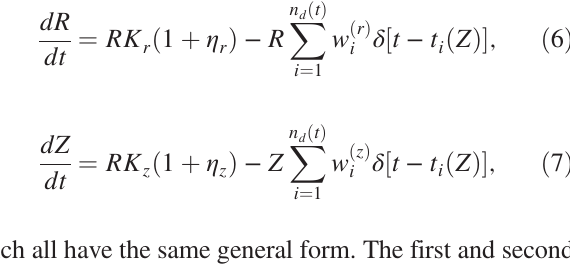
FIG. 4. Noise sources due to growth and division. (a) The effective growth rates λ protein number dynamics during each growth period (between two consecutive division events) with exponential functions. An example of the fitting is shown for L (top) and N (bottom); different colors correspond to different nutrient conditions. (b) λ but not perfect correlation. Deviations from the diagonal correspond to a noise source for c due to growth. The inset shows the distribution of the relative difference between λ (d) The correlation between w ð l Þ and w ð n Þ is high but not perfect. Deviations from the diagonal correspond to another noise source for c due to